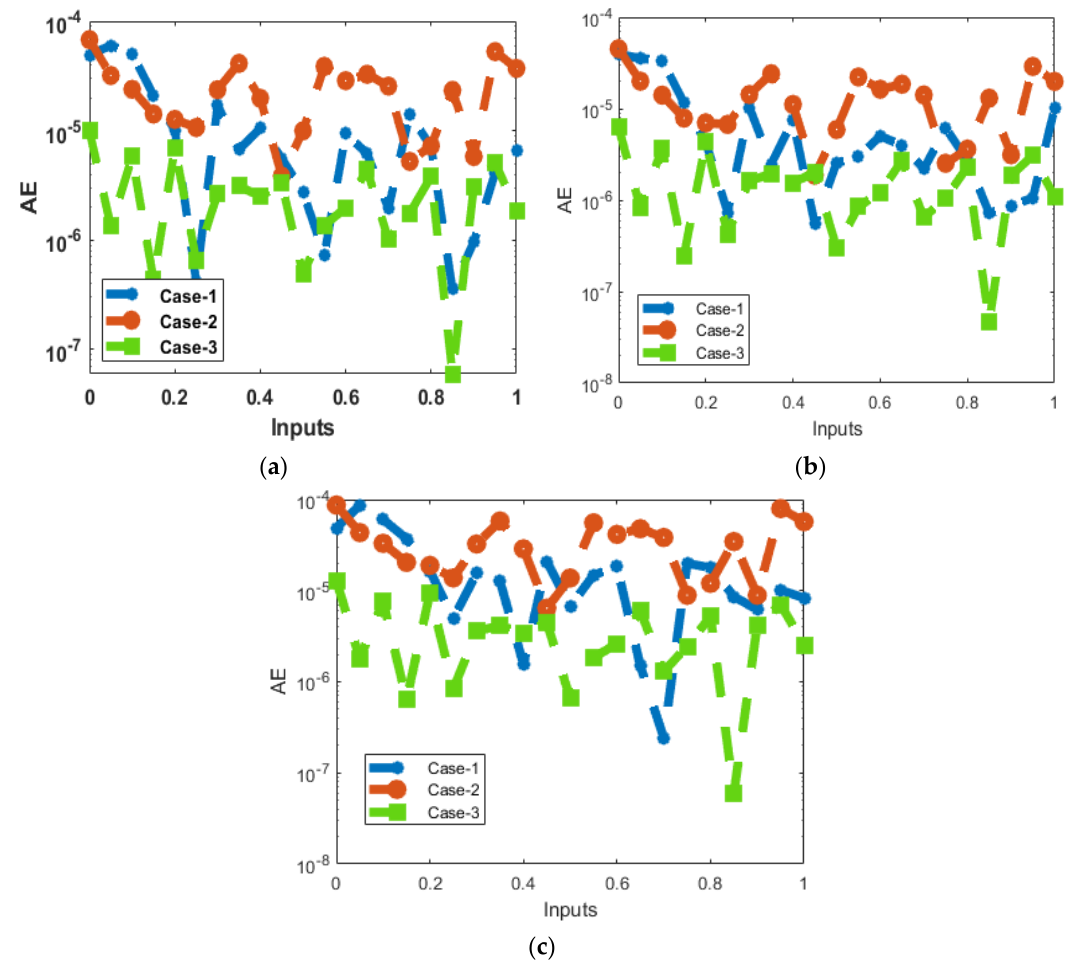
Figure 7. AE for the mathematical form of the FKFS model. ( a ) AE for the logistic prey L ( x ); ( b ) AE for the Holling type M ( x ); ( c ) AE for the top-predator N ( x ).